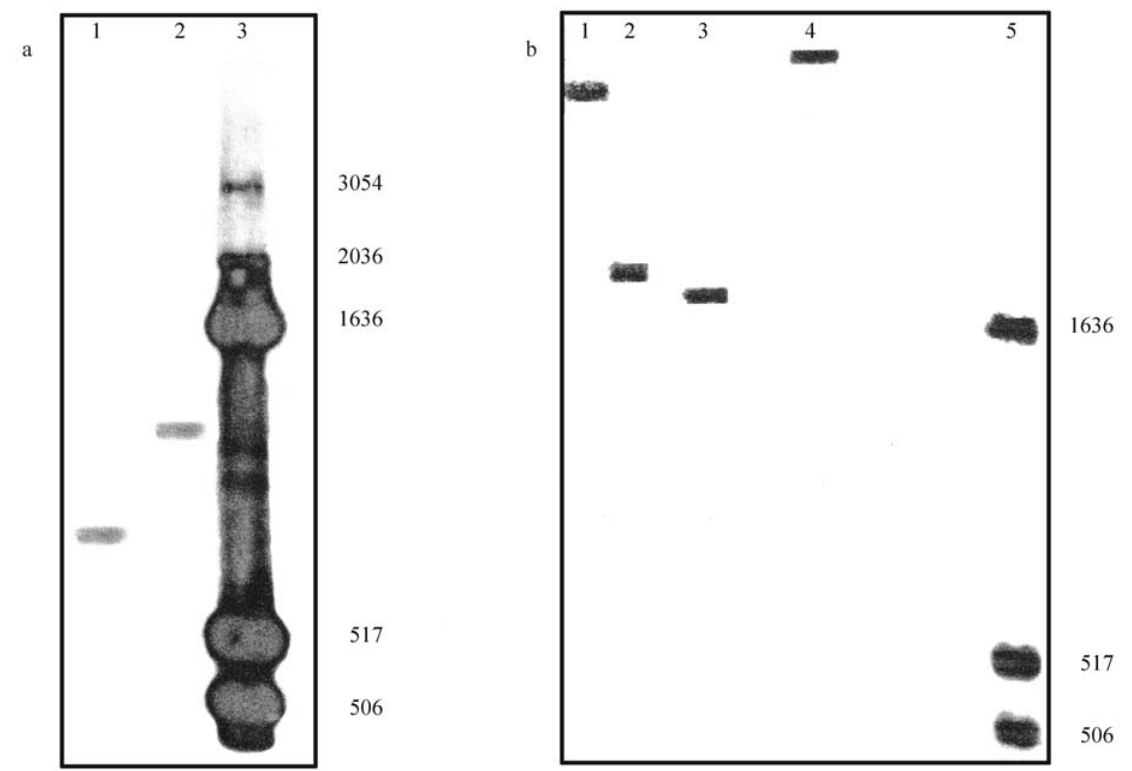
Figure 1 - a) Southern blot analysis of Austrolebias viarius (lane 1) and Austrolebias charrua (lane 2) genomic DNA digested with Hinf-I. The probe used was the amplified Hox fragment in Austrolebias cheradophilus . Lane 3: 1 kb DNA ladder molecular marker (GIBCO). b) Southern blot analysis of Brevoortia aurea (lane 1), Austrolebias adloffi (lane 2), Austrolebias charrua (lane 3) and Austrolebias bellottii (lane 4) genomic DNA digested with Hinf-I. The probe used was the amplified Hox fragment in Austrolebias bellottii . Lane 5: 1 kb DNA ladder molecular marker